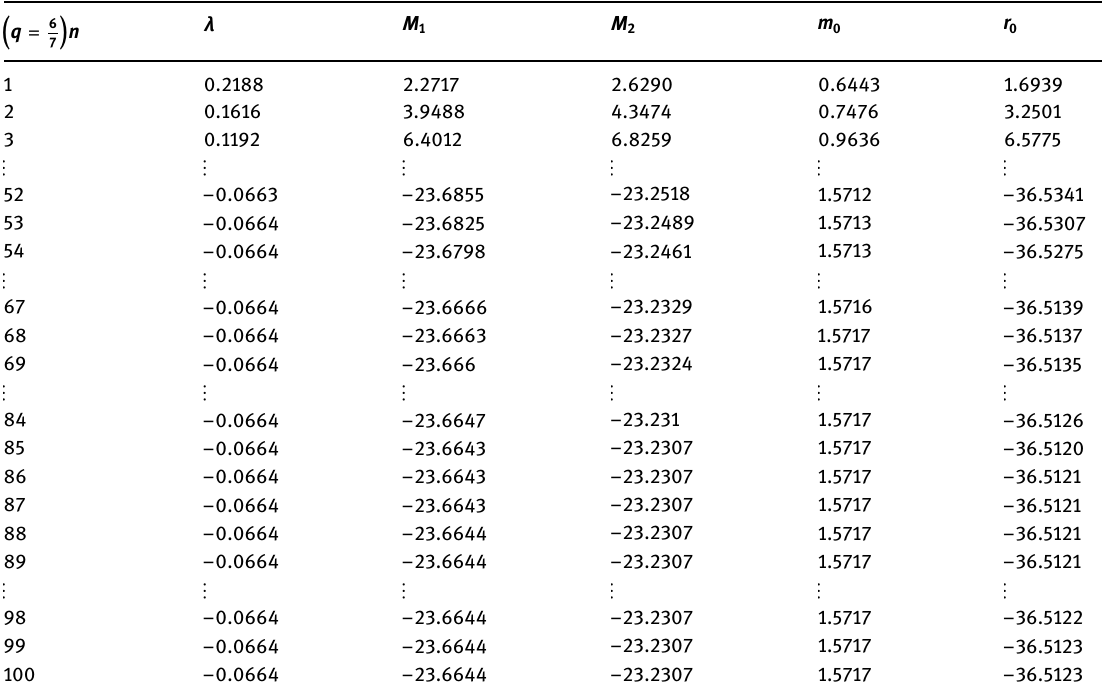
Table 3: Some numerical results of λ , M 1 , M 2 , m 0 , r 0 in Example 4.1 for ∈ t J and = q